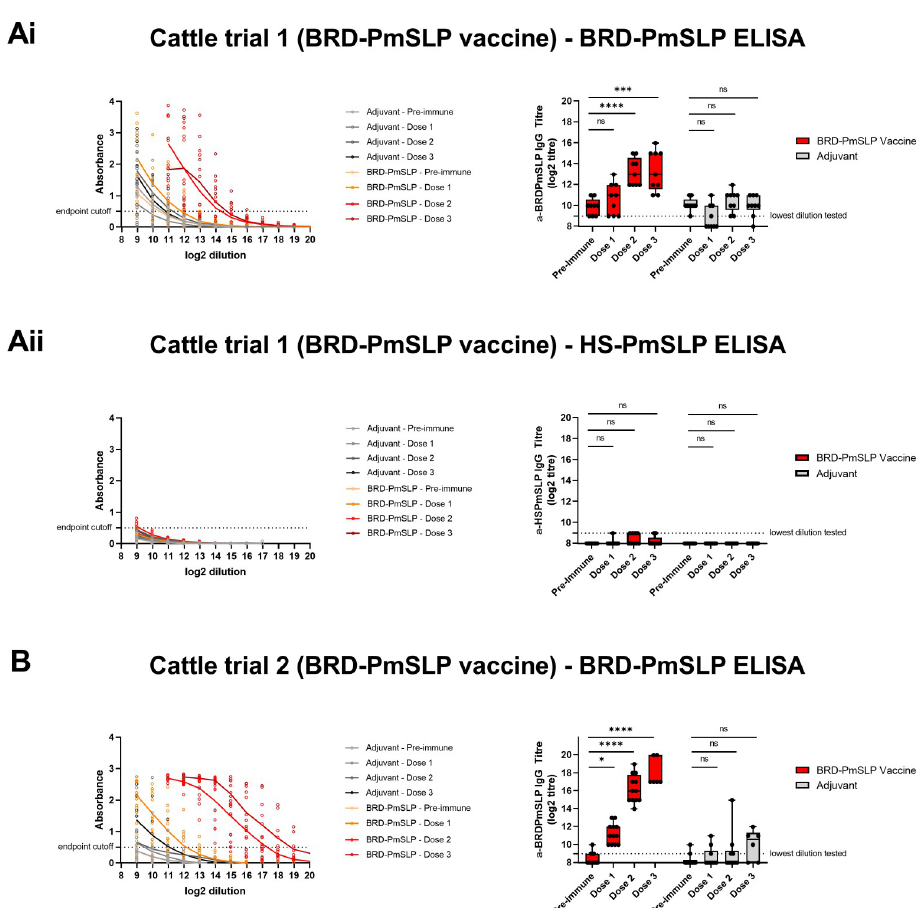
Fig 6. Cattle immunogenicity studies using the BRD-PmSLP vaccine. Ai, B: BRD-PmSLP antigen specific IgG detected in serum of cattle from Trials 1 and 2 respectively. Aii: Cross-reactivity of serum from Trial 1 against HS-PmSLP protein. (Left) Background subtracted absorbance readings obtained for each animal using serially diluted serum. Dotted line represents the cut-off used for calculating IgG titre. (Right) Boxplot displaying individual animals. 2-way ANOVA with Dunnett’s multiple comparisons test performed on log2 transformed data to compare post vaccination titres to baseline. * p < 0.05, *** p < 0.005, **** p < 0.0001, ns = not significant. samples were sent as vials of lyophilized HS-PmSLP antigen or phosphate buffered saline (con- trol) and the corresponding diluent containing adjuvant and were shipped at ambient temper- ature. Samples were stored at 4˚C after receipt, and lyophilized antigen was reconstituted in the diluent prior to each vaccine dose administration. Animals received 2 doses of vaccine or control, 21 days apart (refer to Fig 7C for anti HS-PmSLP serum IgG levels). Approximately two weeks after the booster dose, animals were subcutaneously challenged with 4.4x10 4 CFU of the local Serogroup B P . multocida HS isolate, a dose that had previously been demonstrated to be lethal. In the adjuvant control group, all cattle reached endpoint within 24h. HS-PmSLP vaccinated animals had a survival rate of 87.5% (7 survivors out of 8, HS-PmSLP adjuvanted with Alhydrogel) and 75% (6 survivors out of 8, HS-PmSLP adjuvanted with Montanide Gel 02 and Poly (I:C)), while the strain-matched bacterin was fully protective (8 survivors out of 8) (Fig 8). P . multocida was recovered from the blood and internal organs of all the animals that reached endpoint. Surviving animals had no detectable P . multocida in the blood, indicating that the infection was successfully controlled (S2 Table).